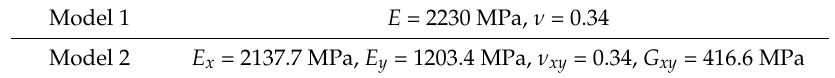
Table 1. Material properties, [3].